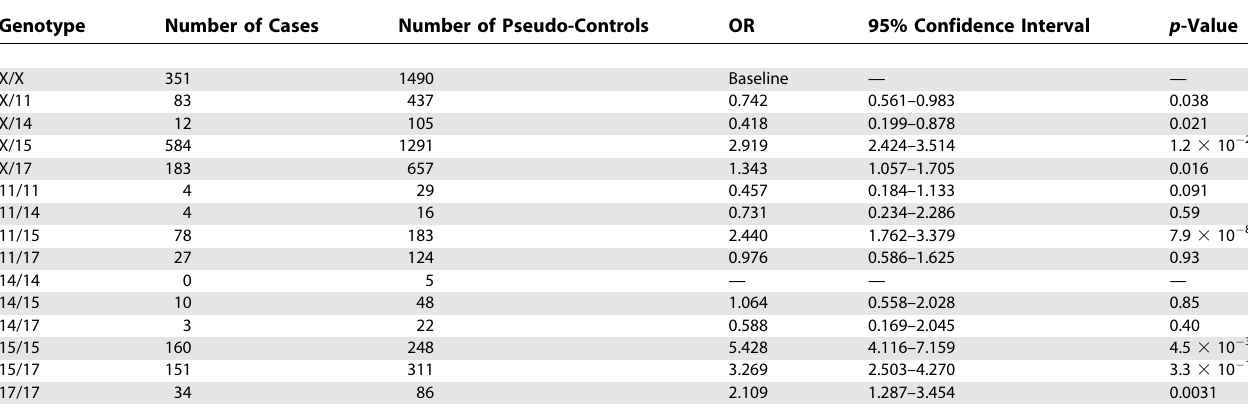
Table 7. Genotypic ORs of MS Made Up of Associated Alleles at the HLA-DRB1 Locus, Relative to HLA-DRB1*X Homozygotes